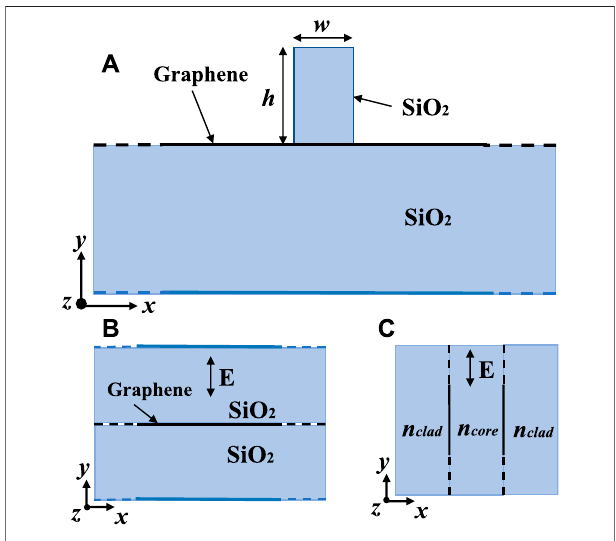
FIGURE 2 | (A) Cross section in the main view of the single dielectric- loaded graphene plasmon waveguide structure. (B) Equivalent three-layered planar waveguide structure of DLGPW. (C) Equivalent three-layered planar waveguide structure based on EIM.